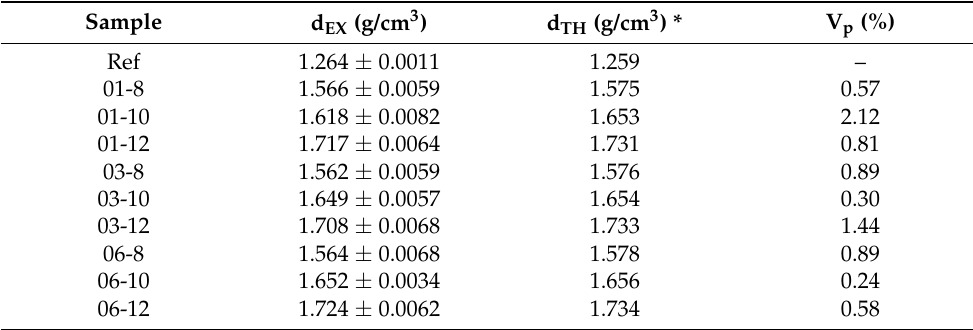
Table 2. Nanocomposite density and void